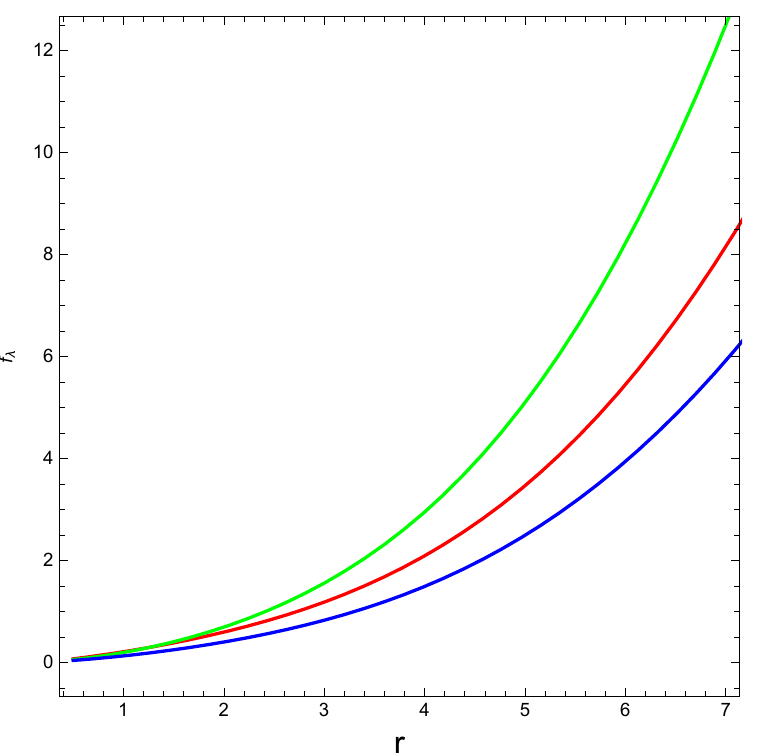
Figure 3. Solution of f ( R ( r )) for R adopted as an exponential function of radius. The evolution of Equation (7) under f ( R ( r )) gravity is provided. We have fixed the values of η 2 , η 3 , a 0 , a 1 , a 2 , K , and C 1 . The red, green, and blue lines correspond to small perturbations of λ 0 , Ψ 0 , and η 1 , respectively. Solving Equations (23), (11), (14), and (16), we obtained a solution set of f ( R ( r )) and the corresponding graph for different values of λ 0 , Ψ 0 , η 1 , η 2 , η 3 , a 0 , a 1 , a 2 , K , and C 1 in Figure